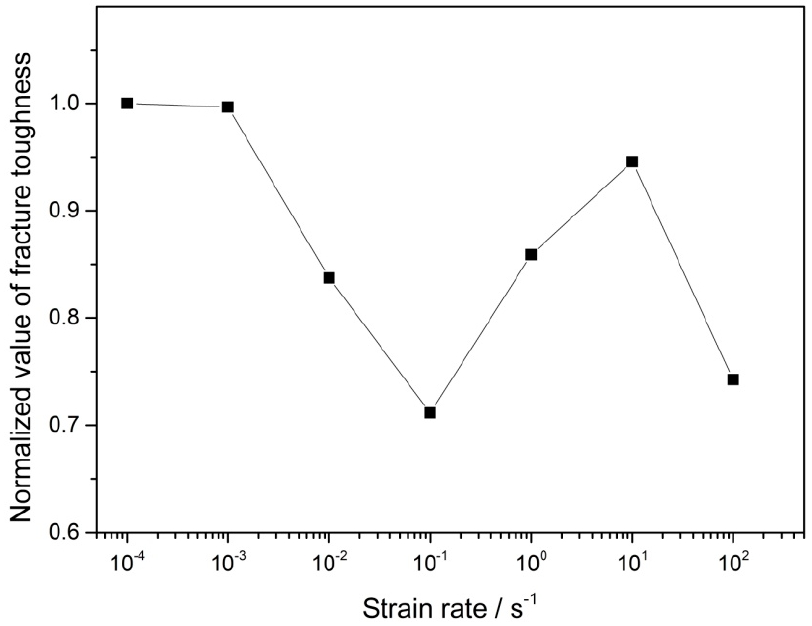
Figure 7. The change of the normalized value of fracture toughness with the strain rate.